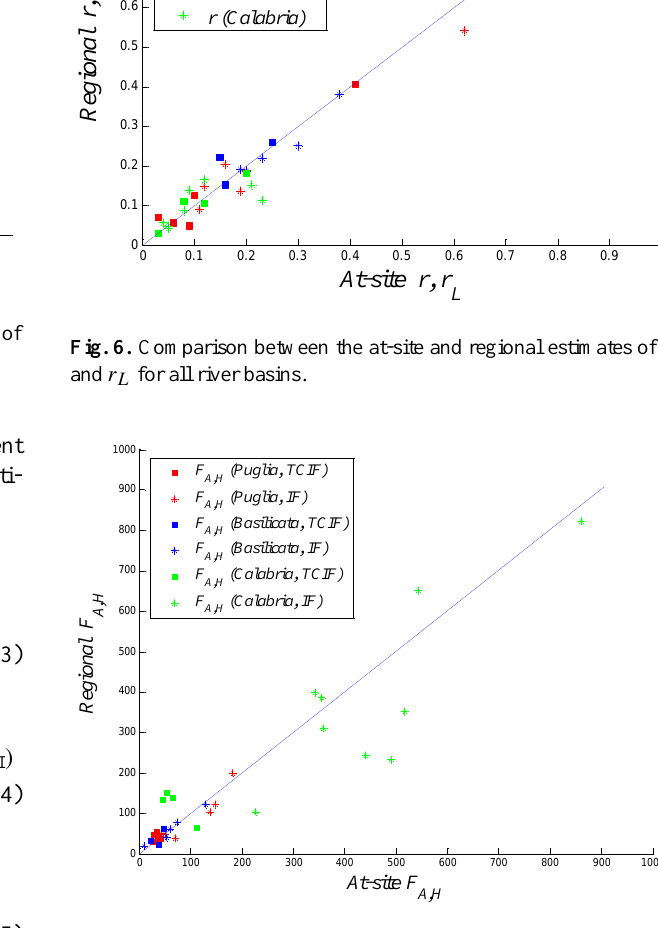
Fig. 7. Comparison between the at-site and regional estimates of F A,H for all river